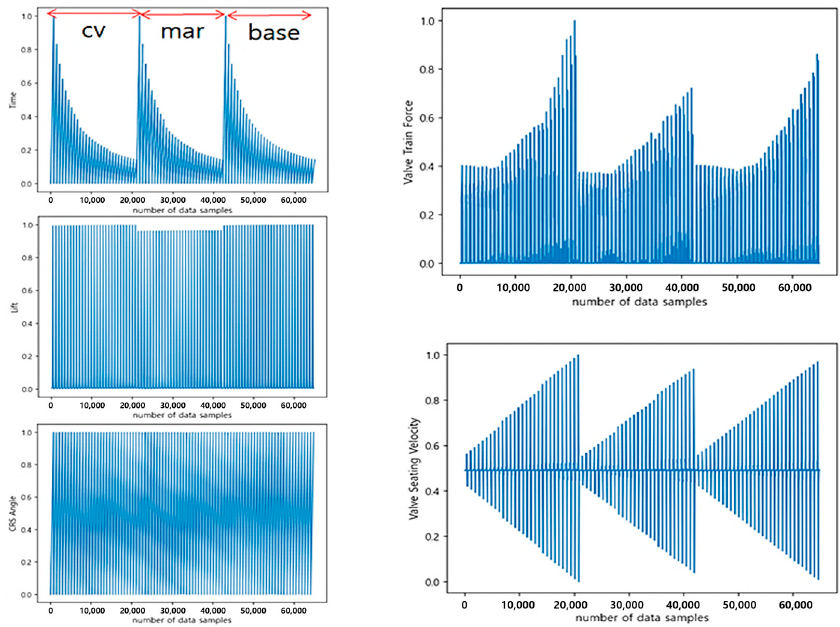
Figure 9. The entire dataset in the diesel engine valve train.